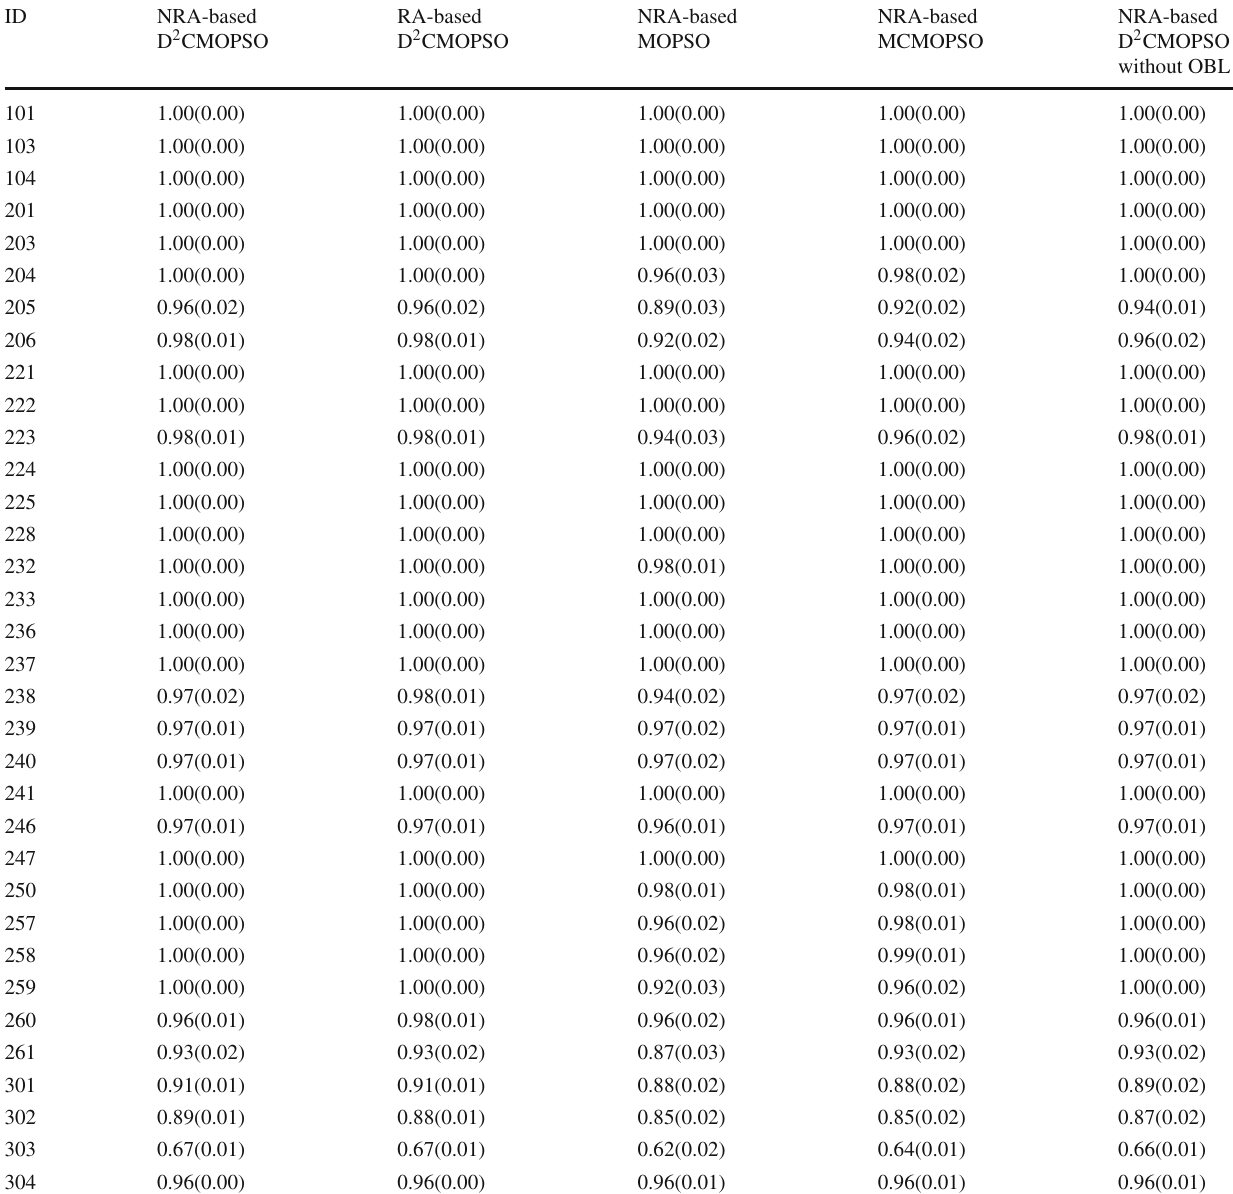
Table 11 Mean and standard deviation of precision for different matching